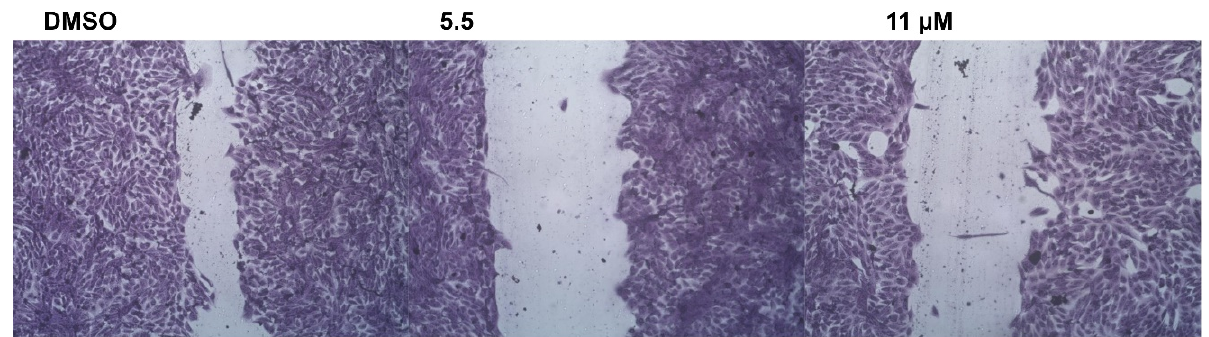
Figure 9. Intracellular measurement of NO for 12b using DAF-FM DA, with JS-K as a positive control.